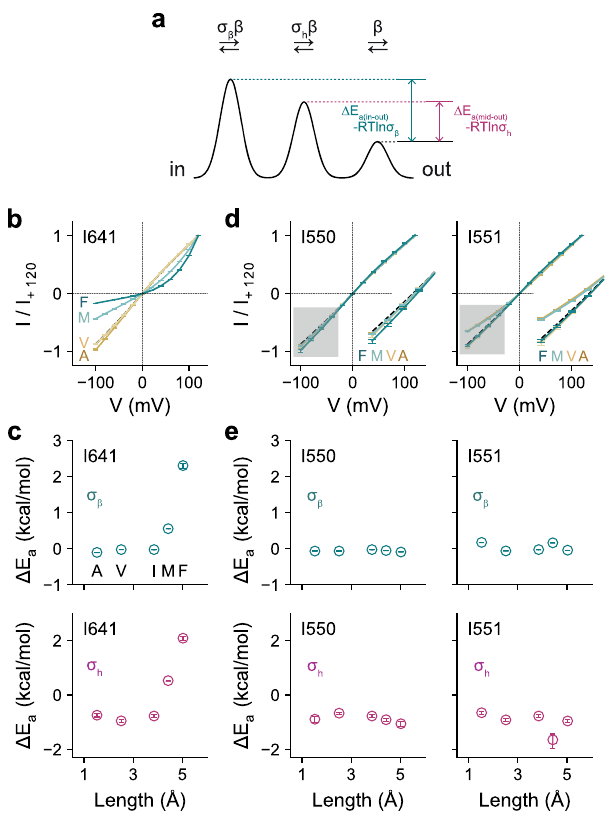
Fig. 6 Effect of sidechain volume on ion conduction in the open state. a Energy pro fi le of a minimal ion permeation model to account for the I-V relations of TMEM16A. b Instantaneous I-V relations of mutations of Ile 641 with increasing sidechain volume at saturating Ca 2 + concentrations. c Energy barrier relative to the outermost barrier in the conduction path at the inner pore entrance (top) and at the middle of the pore (bottom) for Ile 641. d Instantaneous I-V relations of mutations of Ile 550 and Ile 551 with increasing sidechain volume at saturating Ca 2 + concentrations. Inset shows a magni fi ed view of the shaded region. e Energy barrier relative to the outermost barrier in the conduction path at the inner pore entrance (top) and at the middle of the pore (bottom) for the residues Ile 550 and Ile 551. b , d Data are averages of 7, 6, 9, and 7 patches (I641), 6, 7, 5, and 11 patches (I550), and 8, 10, 7, and 10 patches (I551) for A, V, M, and F respectively, errors are SEM. Solid lines are fi ts to a model of ion permeation (Eq. 2). Dashed lines show the relation of WT. c , e Data are calculated using Eq. 3 from the best- fi t values of the averaged data shown in b and d respectively, errors are 95% con fi dence intervals. during cryo-EM sample preparation. Cells were resuspended and solubilized in 150 mM NaCl, 5mM EGTA, 20mM HEPES, 1× cOmplete protease inhibitors (Roche), 40µgml – 1 DNase (AppliChem), 2% GDN (Anatrace) at pH 7.4 by gentle mixing for 2h. The solubilized fraction was obtained by centrifugation at 16,000 × g for 30 min. After fi ltration with 0.5µm fi lters (Sartorius), the supernatant was incubated with streptavidin UltraLink resin (Pierce, Thermo Fisher Scienti fi c) for 2 h under gentle agitation. The beads were loaded onto a gravity column and were washed with 60 column volume of SEC buffer containing 150mM NaCl, 2mM EGTA, 20 mM HEPES, 0.01% GDN at pH 7.4. The bound protein was eluted by incubating the beads with 3 column volume of SEC buffer supplemented with 0.25mg ml – 1 3C protease for 30min. The eluate was concentrated using a 100 kDa cutoff fi lter, fi ltered through a 0.22µm fi lter, and loaded onto a Superose 6 10/300 GL column (GE Healthcare) pre-equilibrated with SEC buffer. Peak frac- tions containing the protein were pooled, concentrated, fi ltered through a 0.22 µm fi lter, and used immediately for cryo-EM sample preparation. Electron microscopy sample preparation and data collection . 2.5µl of puri fi ed protein, concentrated to ~2 mgml – 1 and pre-incubated with 1.5 mM diC8-PI(4,5) P 2 (Echelon Biosciences) for at least 30min at 4 °C, was applied onto holey carbon